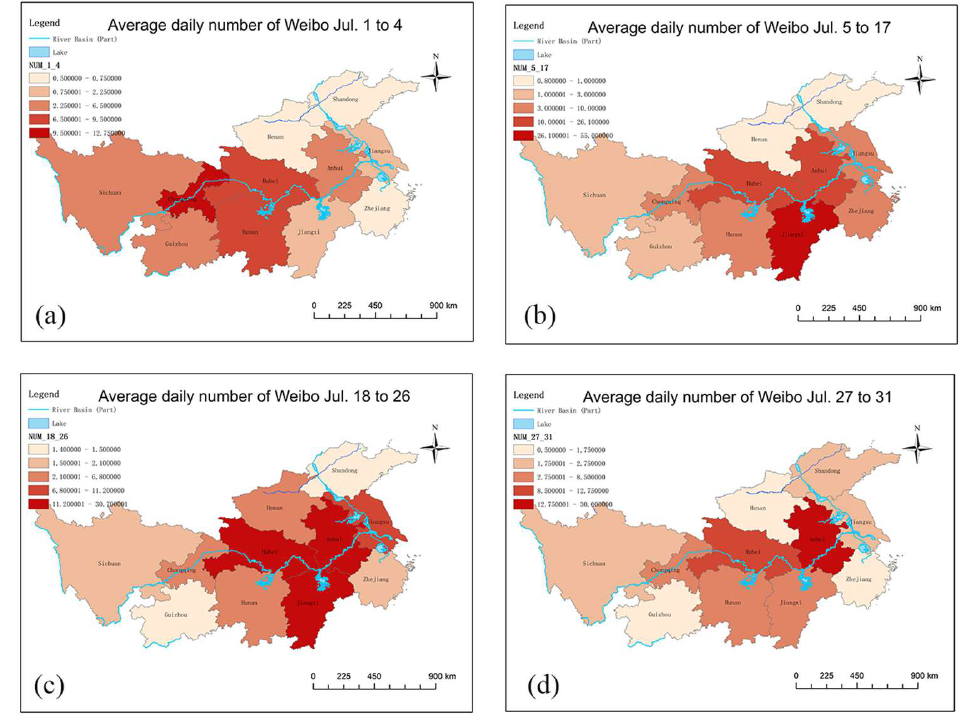
Figure 16. The average number of Weibos at ( a ) 1 July to 4 July, ( b ) 5 July to 17 July, ( c ) 18 July to 26 July, and ( d ) 27 July to 31 July.